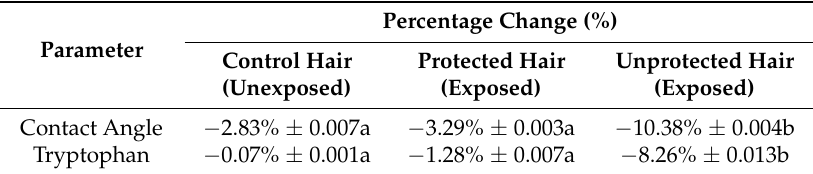
Table 2. Percentage change of the contact angle and tryptophan content of the protected and unprotected virgin hair in the experimental group after the sixth treatment.